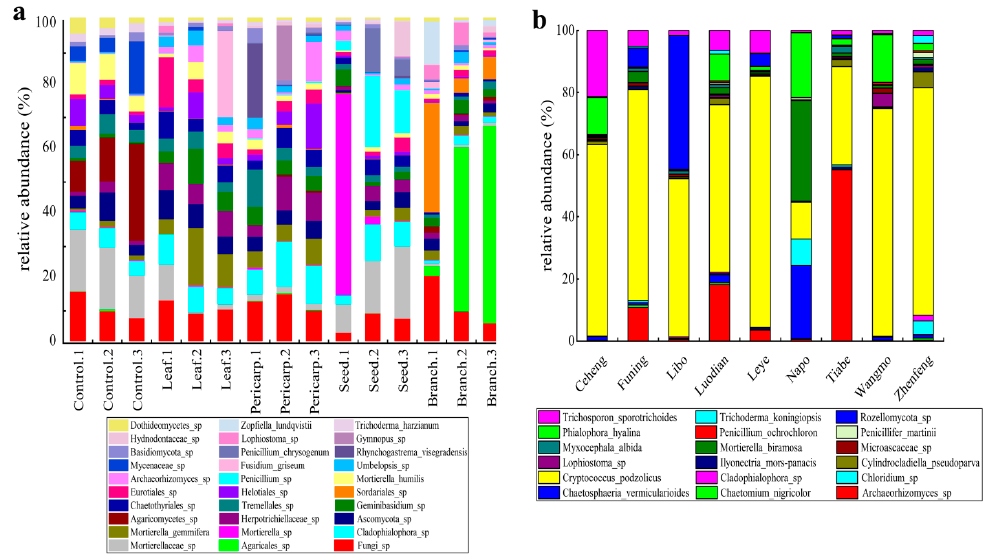
Figure 6. Relative abundance at the species level. Notes: ( a ) Relative abundance of the top 30 species under different treatments. ( b ) The common fungal species in nine areas.